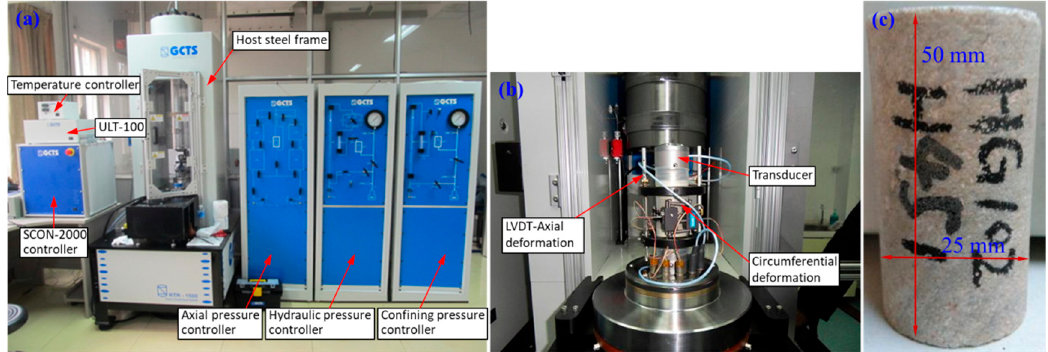
Figure 6. ( a,b ) GCTS RTR-1500 triaxial test system and (c) cylindrical glutenite specimen prepared for testing.